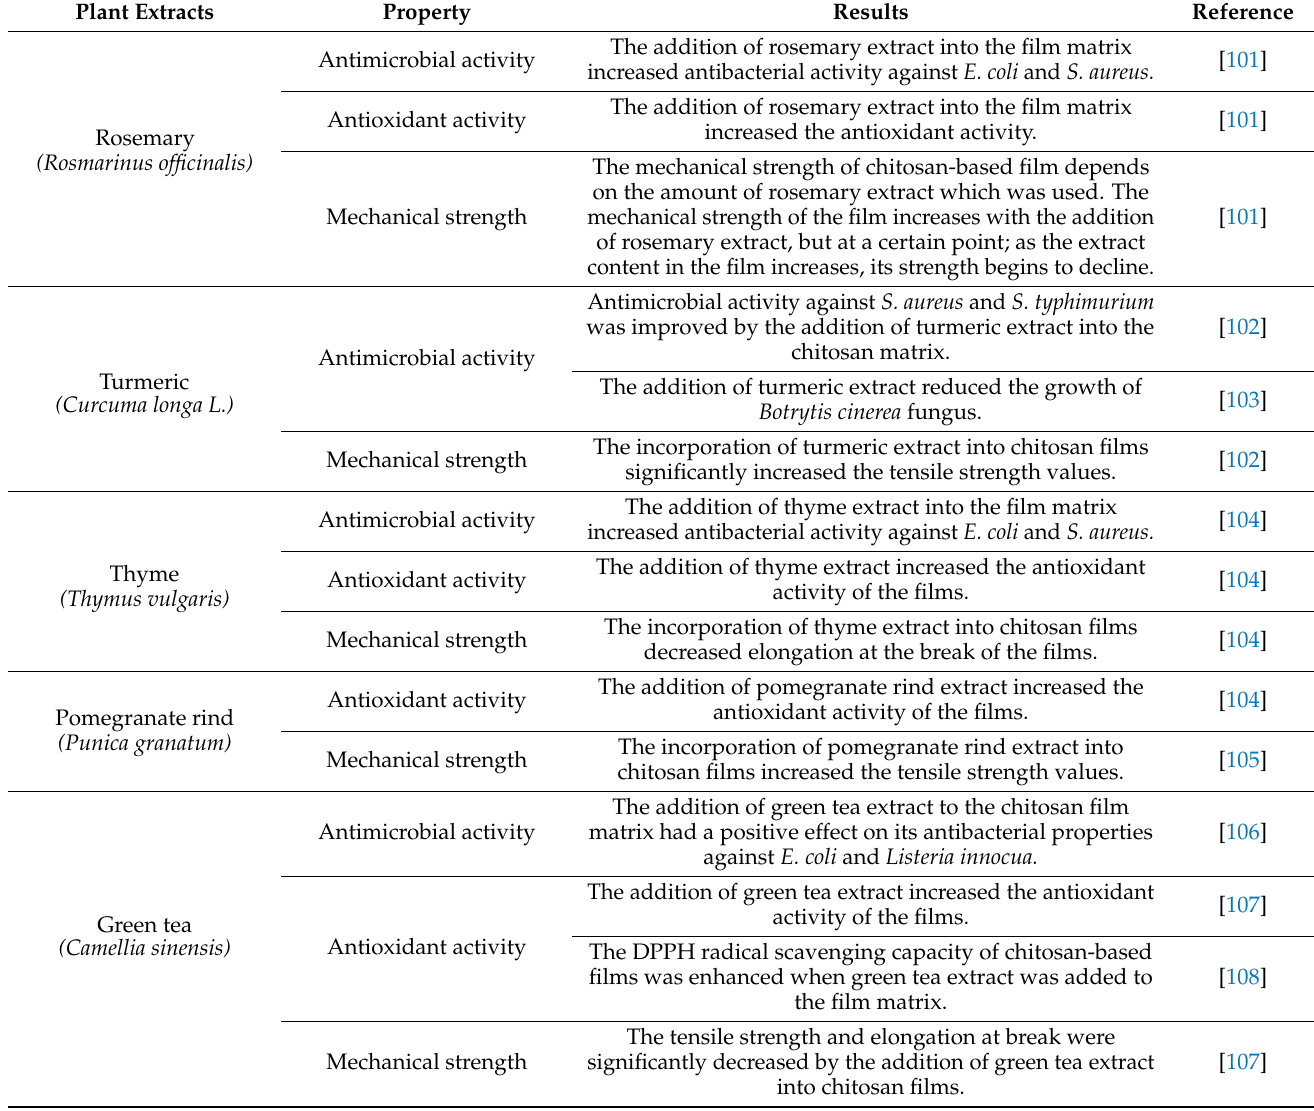
Table 2. The list of the most common used plant extracts and their influence on the properties of the obtained